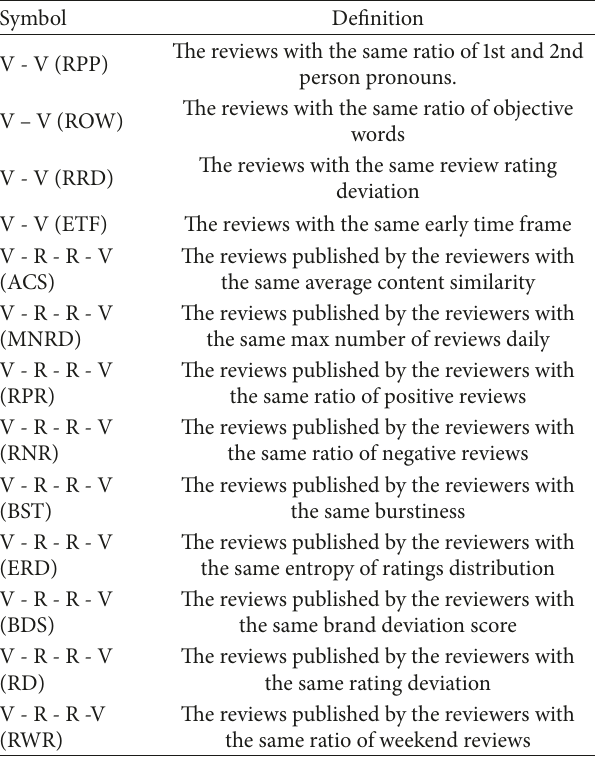
Algorithm 1 is named as StaticTargetProductDetection ,